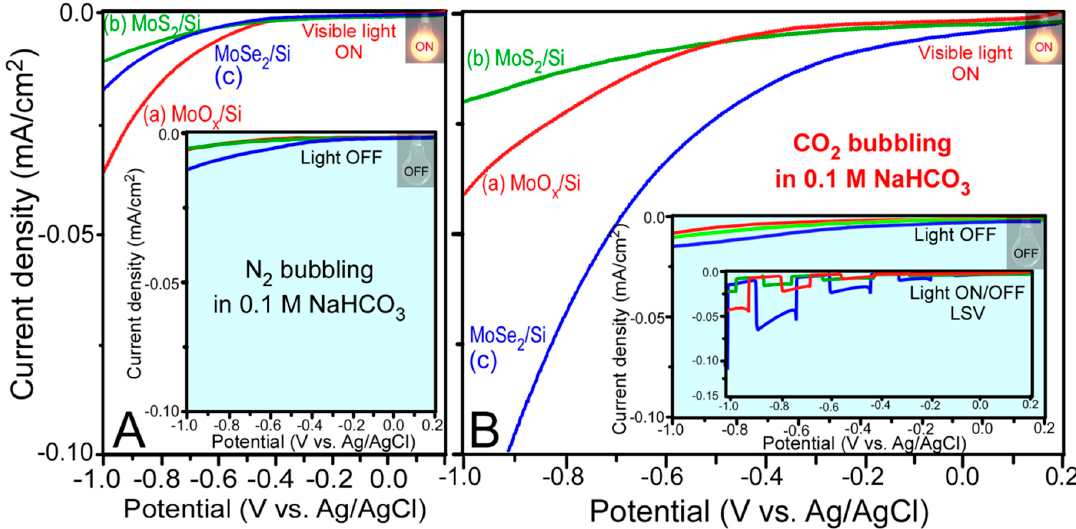
Figure 5. Linear sweep voltammetry curves (voltage range: + 0.2~1.0 V) in N 2 - ( A ) and CO 2 -purged ( B ) 0.1 M NaHCO 3 electrolyte at a scan rate of 10 mV / sec under dark (in the corresponding inset Figure) and the visible light exposure condition for (a) MoO x / Si, (b) MoS 2 / Si and (c) MoSe 2 / Si samples. The inset ( B ) shows the light ON-and-OFF LSV curves.